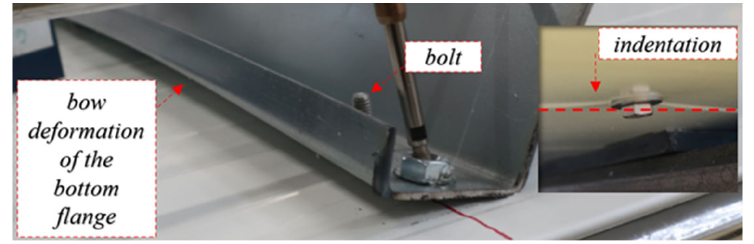
Figure 11. Failure mechanisms in stage II in connection using bolts: indentation at the bottom facing and bow deformation of the bottom flange.